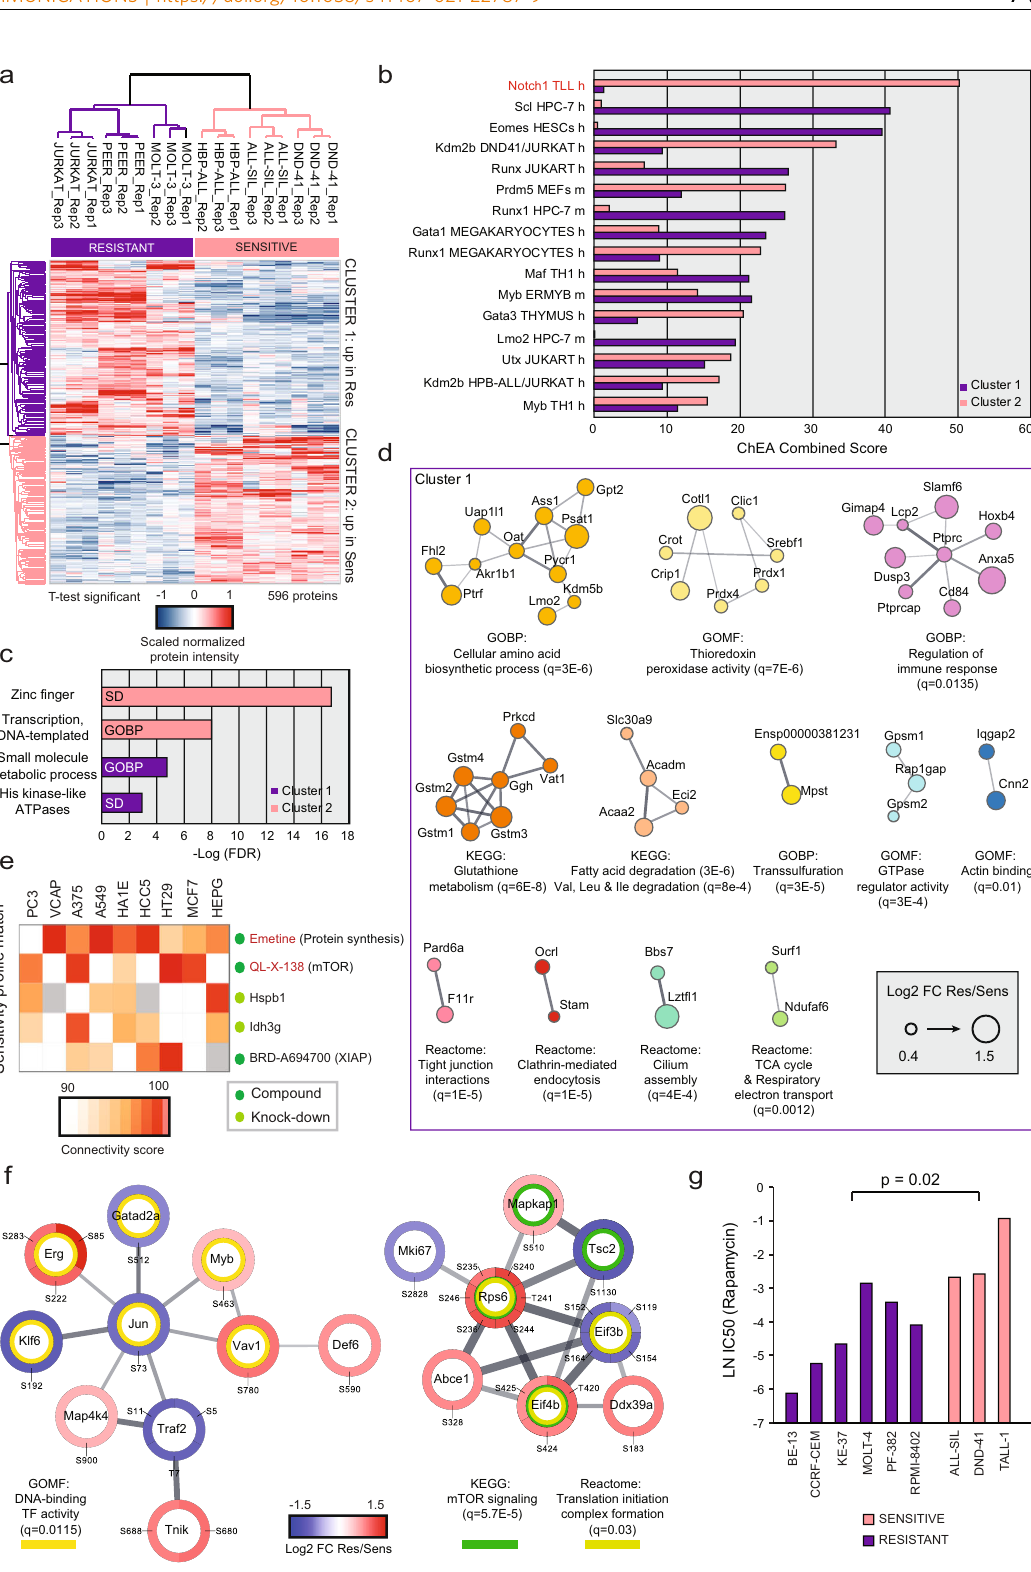
KEGG: mTOR signaling (q=5.7E-5)